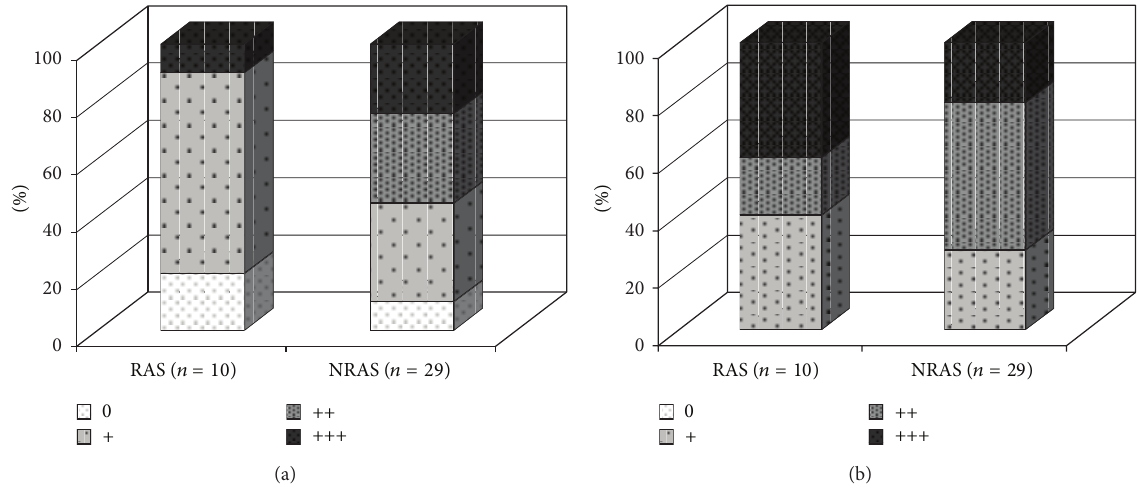
Figure 3: (a) Degree of lymphocyte infiltration in RAS as compared to NRAS. Number of valves given as percent (%) of ( 𝑛 ). (b) Degree of macrophage infiltration in RAS as compared to NRAS. Number of valves given as percent (%) of ( 𝑛 ). RAS = rheumatic aortic stenosis, NRAS = nonrheumatic aortic stenosis.